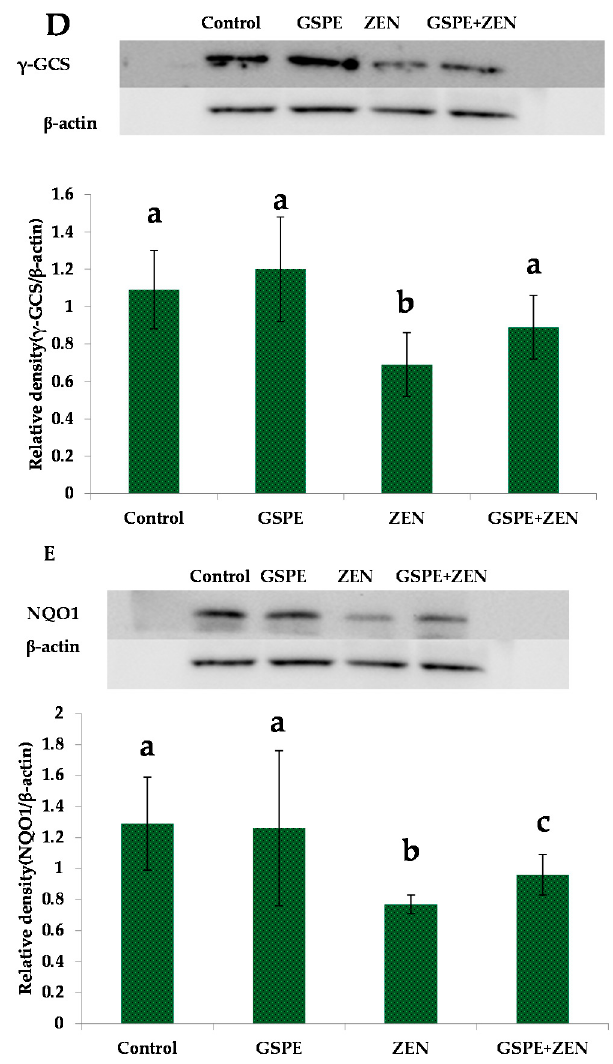
Figure 3. Pretreatment effects of GSPE on ZEN-induced the protein expression levels of the Nrf2/ARE signaling pathway in the liver of mice. ( A ) Nuclear erythroid2-related factor2 (Nrf2); ( B ) glutathione peroxidase (GSH-Px); ( C ) hemeoxygenase-1 (HO-1); ( D ) γ -glutamyl cysteine synthetase ( γ -GCS) and ( E ) quinone oxidoreductase 1 (NQO1). Values expressed as mean ± SE in each group. Values are mean ± SEM of ten mice in each group. a,b,c Means with different letters are significantly different, p < 0.05.